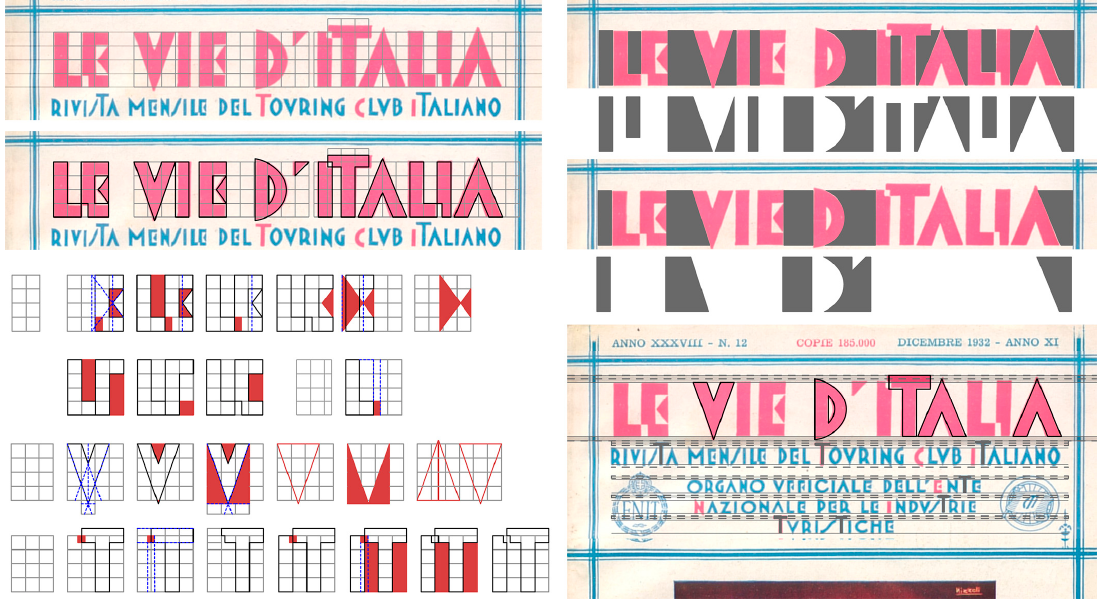
Figure 6. The new graphical look of the magazine renewed in 1932. The design of the characters, the kerning, the spacing between the words and the interline